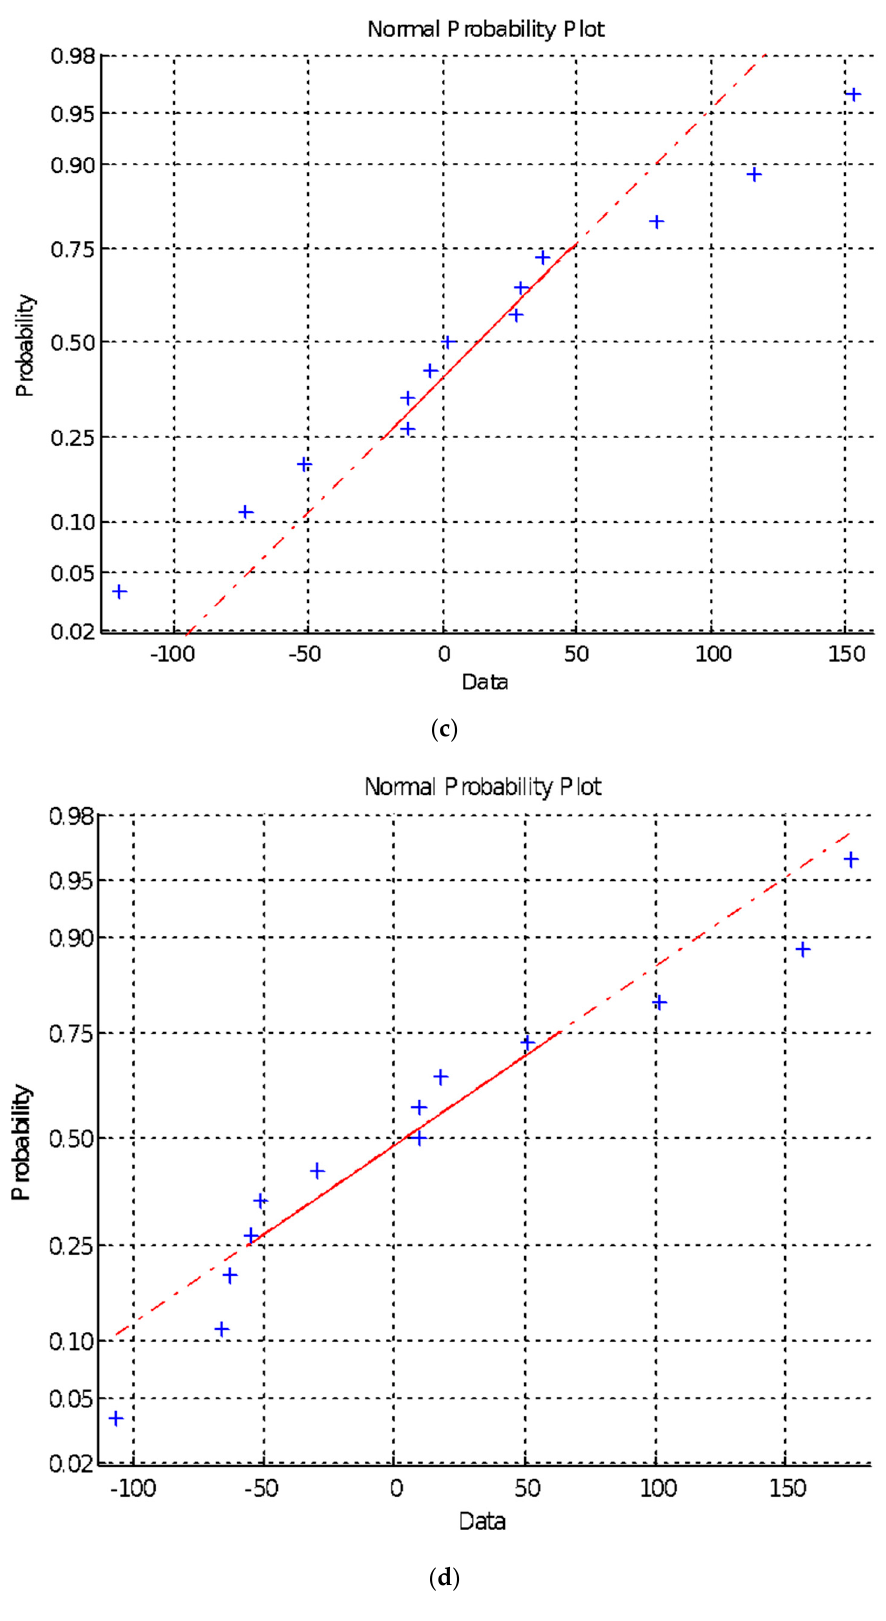
Figure 6. The relationship between gradient and mean square error of training data. ( a ) P-4c-k; ( b ) P-7c-k; ( c ) P-10c-k; ( d ) P-13c-k.